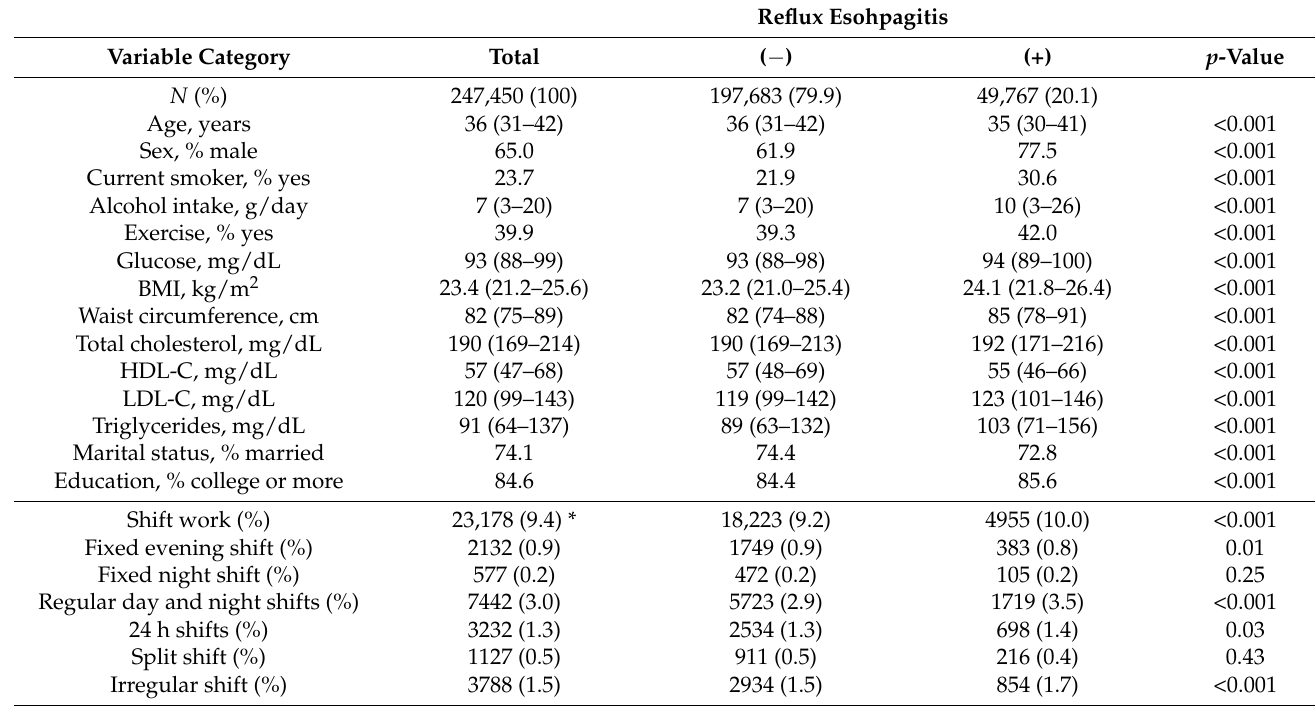
Table 1. General characteristics of the study subjects.